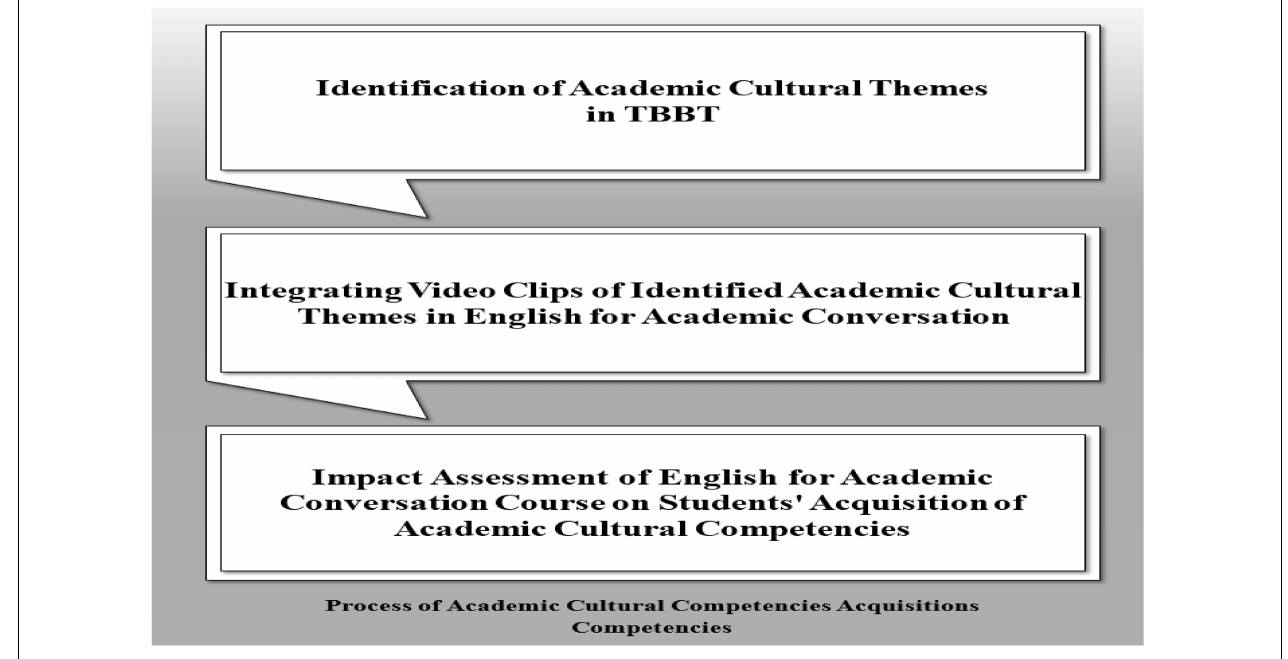
FIGURE 2 | Research design on the process of academic cultural competencies